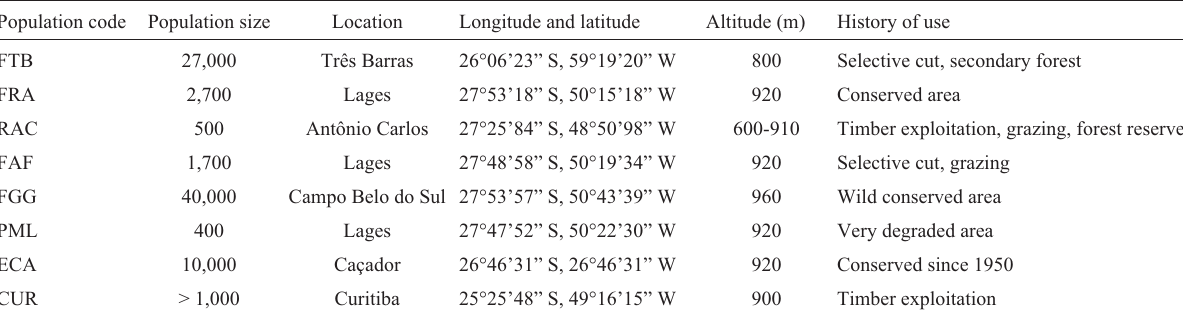
Table 1 - Geographic location, altitude, population size, forest type and history of use of eight A. angustifolia populations. Population code Population size